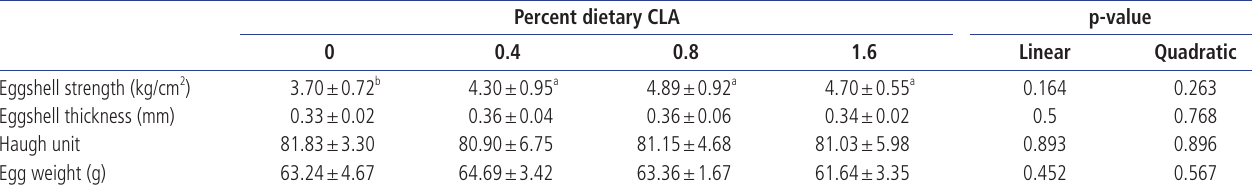
Table 4. Effects of CLA on egg quality of laying hens